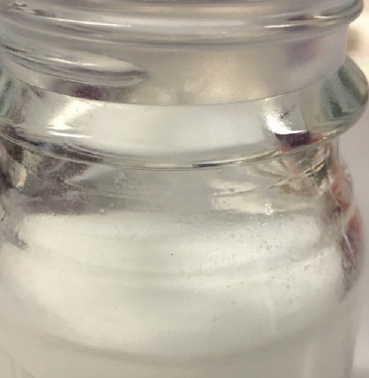
Figure A5. Image of the well-dispersed, stirred HDK-H20S suspension. There was no visible indi- cation of non-dispersed powder.